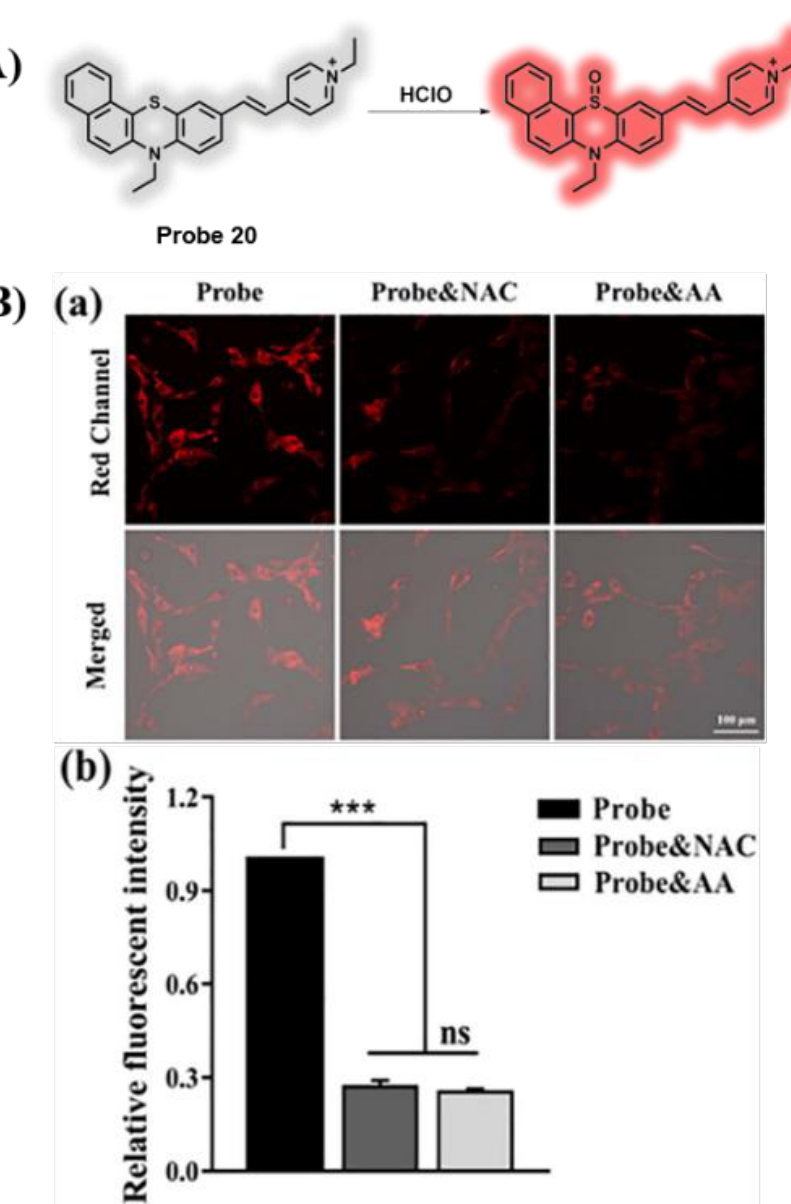
Figure 16. ( A ) Imaging mechanism of probe 20 ; ( Ba ) visualization of HClO fluctuations in diabetic HLE cells after drug (100 µ M NAC or AA) treatment; ( Bb ) quantitative statistical analysis. Conditions: λ ex = 405 nm, λ em = 520 − 620 nm. Scale bar: 100 µ m. ns, no significance; *** p < 0.001 by one-way ANOVA. Adapted from Reference [96]. Copyright 2022, Elsevier B.V.